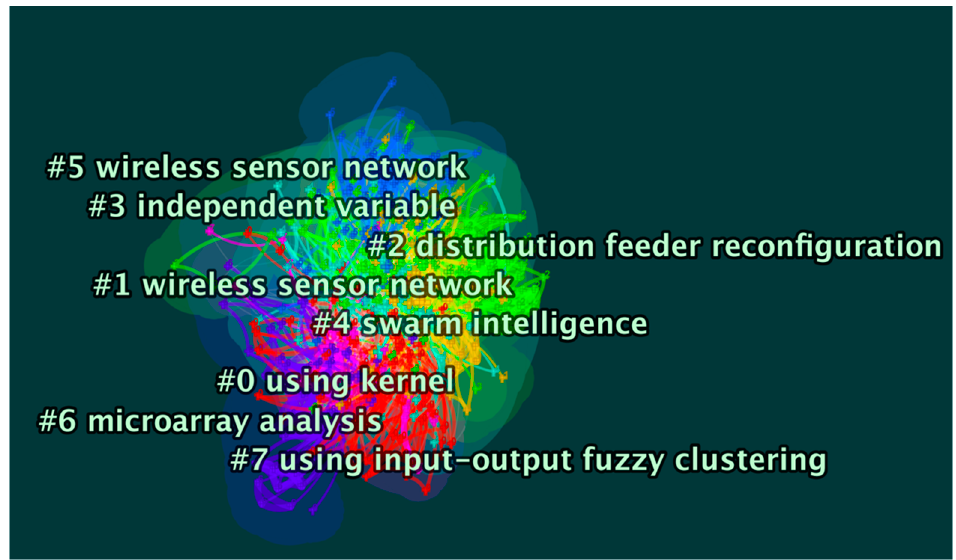
Figure 4. Network and clusters with a total of 456 nodes, 3137 links using 1717 qualified records.